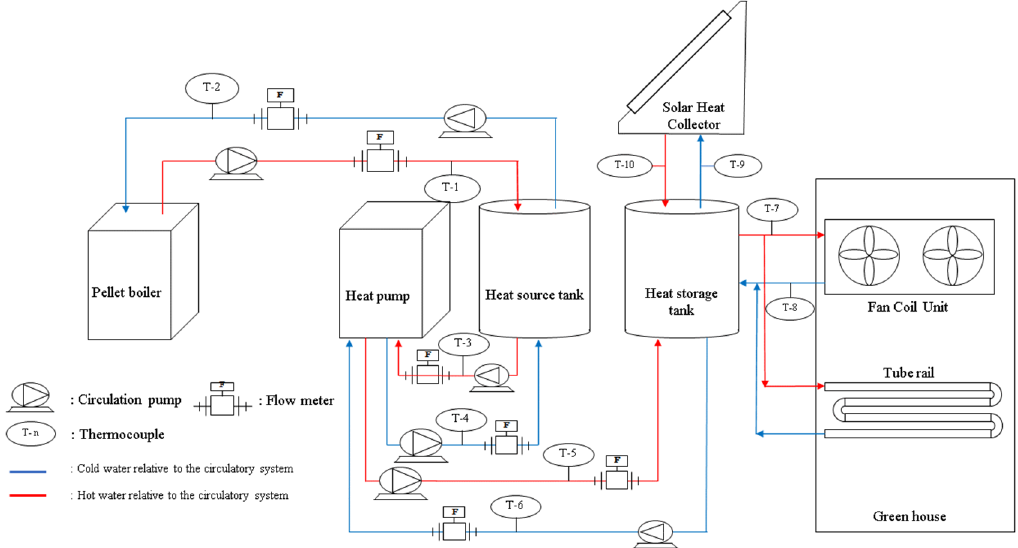
Figure 2. Schematic diagram of the combined heating system.